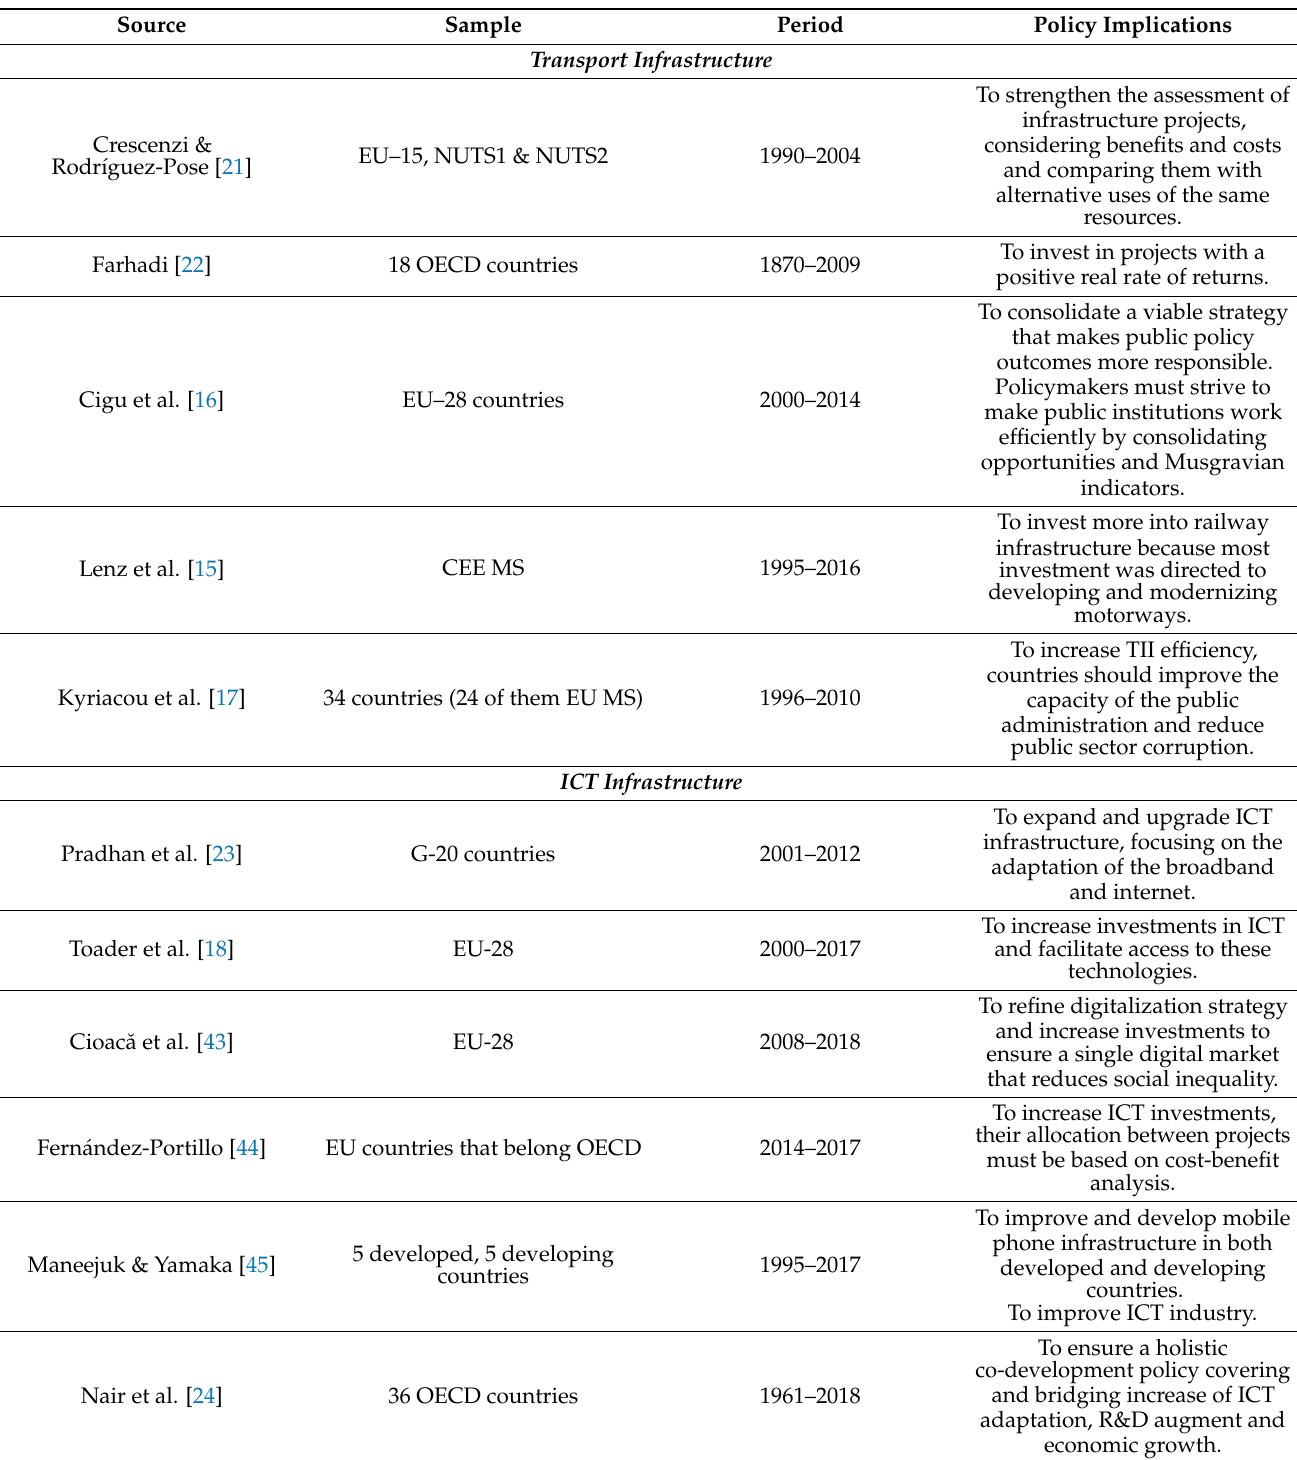
Table 4. Policy implications provided in previous papers investigating transport and ICT infrastruc- ture development